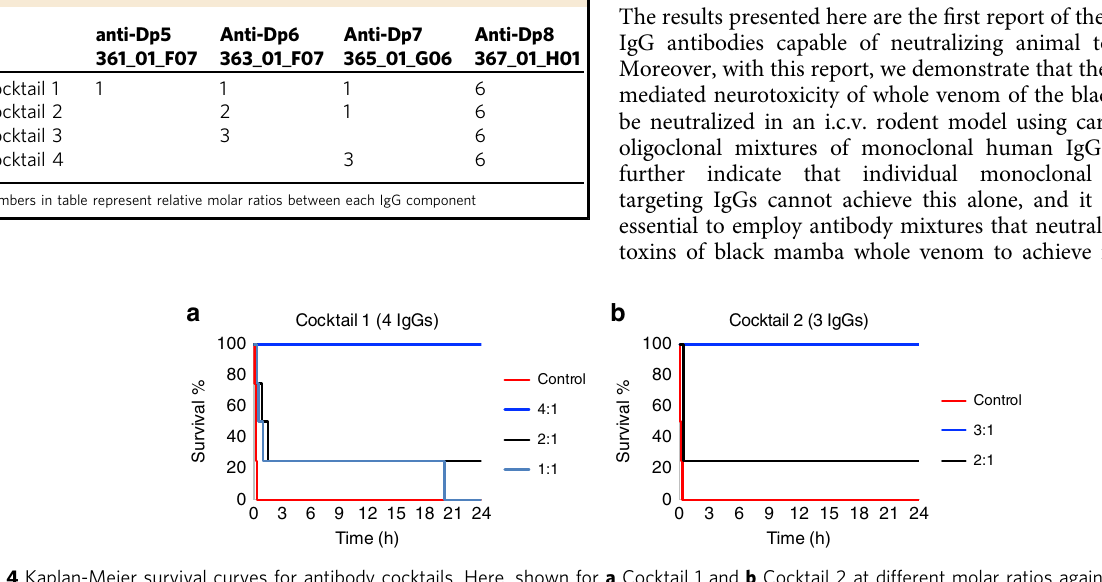
Table 4 Composition of the IgG cocktails